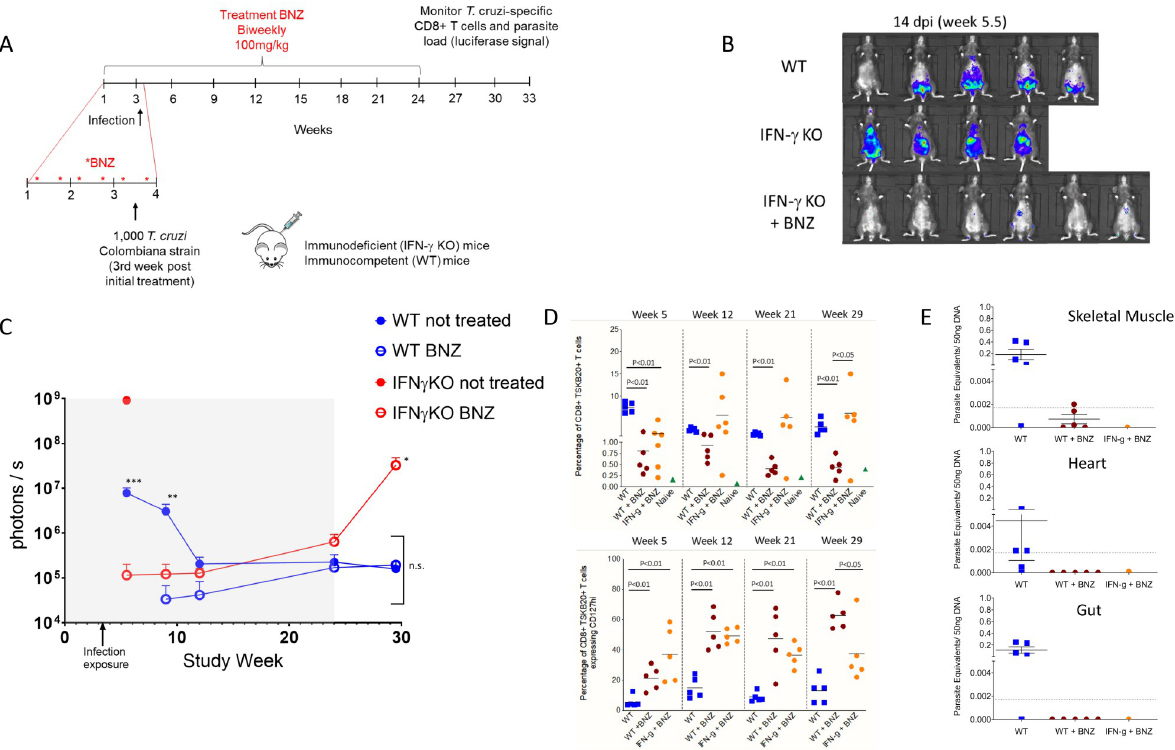
Fig 1. (A) Schematic representation of prophylactic treatment, infection, and monitoring of mice. WT and IFN γ deficient mice were treated biweekly with 100mg/kg of BNZ over 24 weeks. After the second week of treatment, mice were infected (5–6 animals/group) intraperitoneally with 10 3 trypomastigotes of the Luciferase-expressing Colombiana strain of T . cruzi . Control groups of mice were infected and left untreated. (B) Representative images showing bioluminescent signal in mice (ventral view) at 14 days post-infection exposure. (C) Parasite bioluminescence quantification following D-luciferin injection was measured at the indicated times in the study period. Each data point represents the mean of bioluminescence from 3–6 mice expressed on a logarithmic scale as mean photons/second ± /- standard error of the mean. Grayed box marks the prophylaxis period. � p < 0.03 relative to both WT groups; �� p < 0.008 relative to both BNZ-treated groups; ��� p < 0.005 relative to BNZ-treated IFN γ KO group; n.s. bracketed data points are not statistically different. (D) Percentage of CD8 + blood lymphocytes specific for the T . cruzi TSKb20 epitope (top) and expressing the T cell central memory marker CD127 (bottom) during the study course (E) T . cruzi DNA determined by quantitative real time polymerase chain reaction in the skeletal muscle, heart, and intestine of untreated and BNZ-treated mice at week 33 of the study (~30 weeks post-infection). Dashed line indicates limit of quantification based on the range of the standard